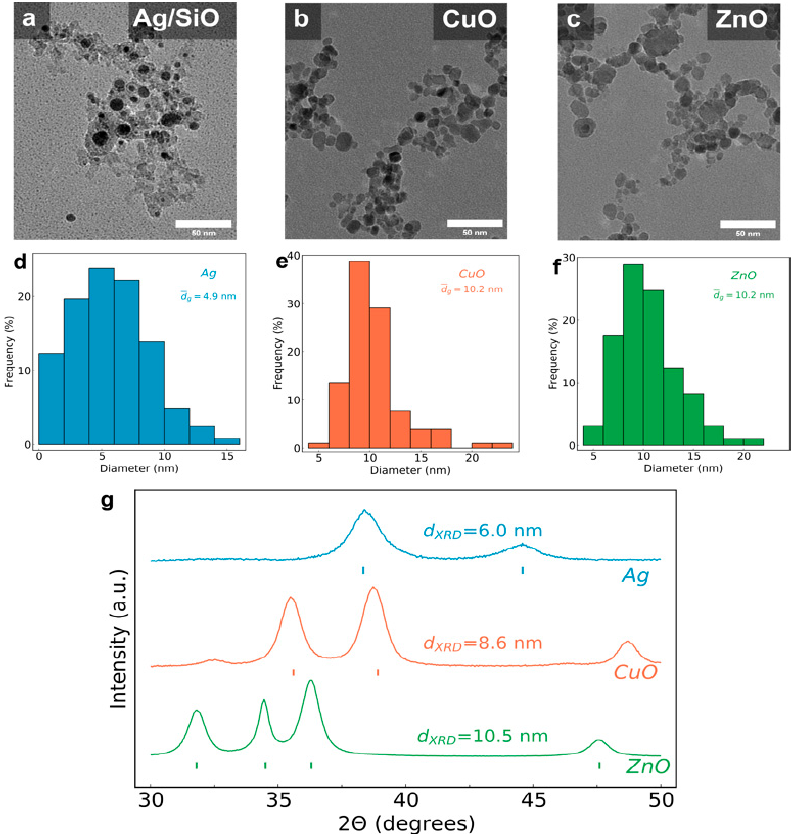
Figure 2. TEM images of the scraped-off nanoparticles from the annealed nanocoatings on the glass substrates for the ( a ) Ag/SiO 2 , ( b ) CuO and ( c ) ZnO samples. ( d – f ) Particle size distributions obtained from the TEM images for all three samples. ( g ) X-ray diffraction patterns of the nanocoatings on the glass substrates along with their average crystal size.